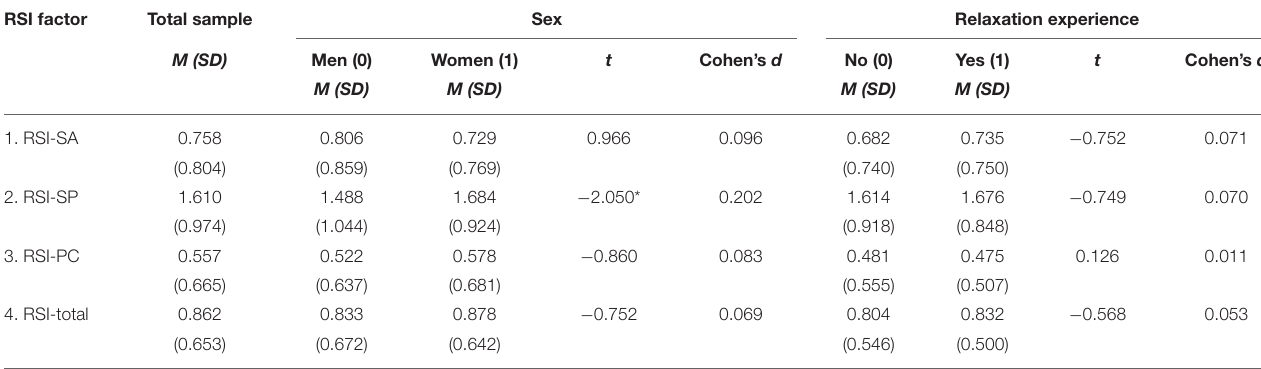
TABLE 5 | Descriptive statistics for RSI scores and their differences by sex and relaxation experience. RSI